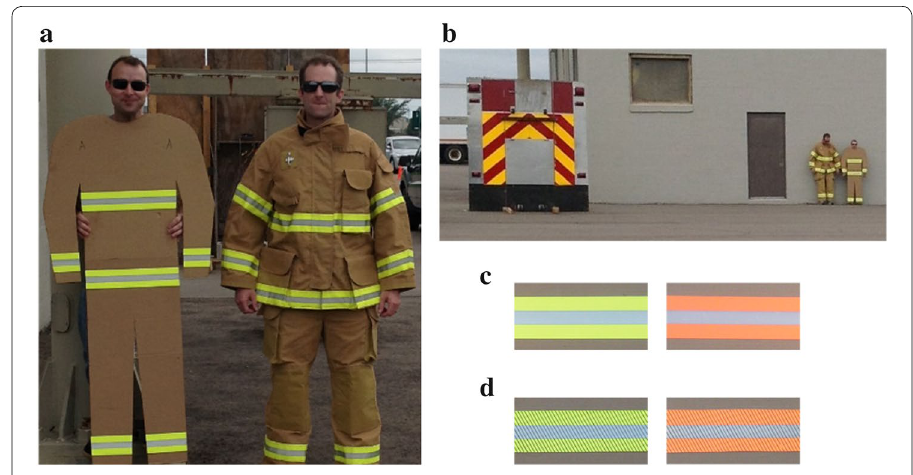
Fig. 1 a An experimenter holding a trim stimulus used in study 1 with the minimal trim pattern prescribed by the NFPA 1971–2013 standard (left) and an experimenter wearing firefighter turnout gear (right); b trim stimulus and turnout gear when viewed from afar; c traditional solid lime yellow and orange-red trim samples with alternating bands of fluorescent, retroreflective, and fluorescent material; d more recently developed segmented lime yellow and orange-red trim